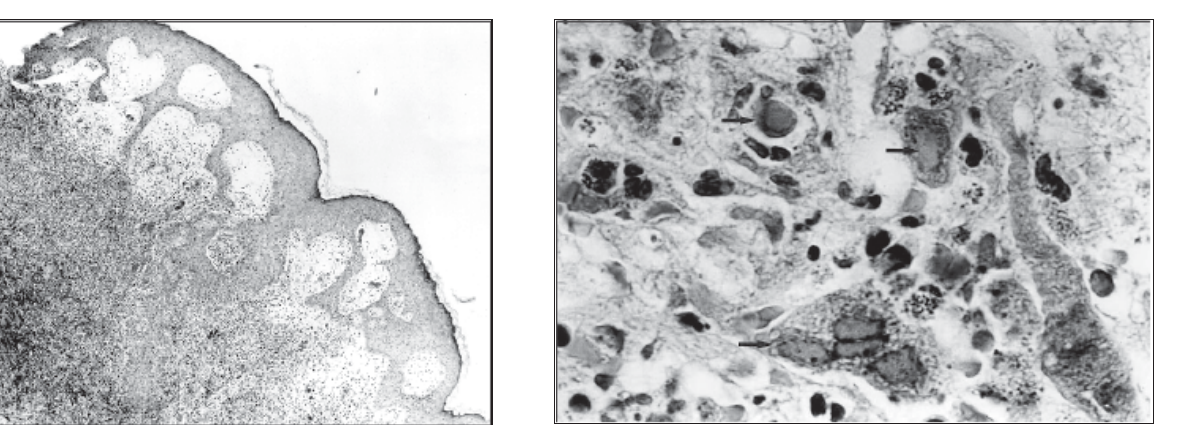
Figure1) Hematoxylinandeosinstainedsectionofthepatient’sbreast biopsy showing ballooning and reticular degeneration of the epider- mis and a mixed inflammatory cell infiltrate